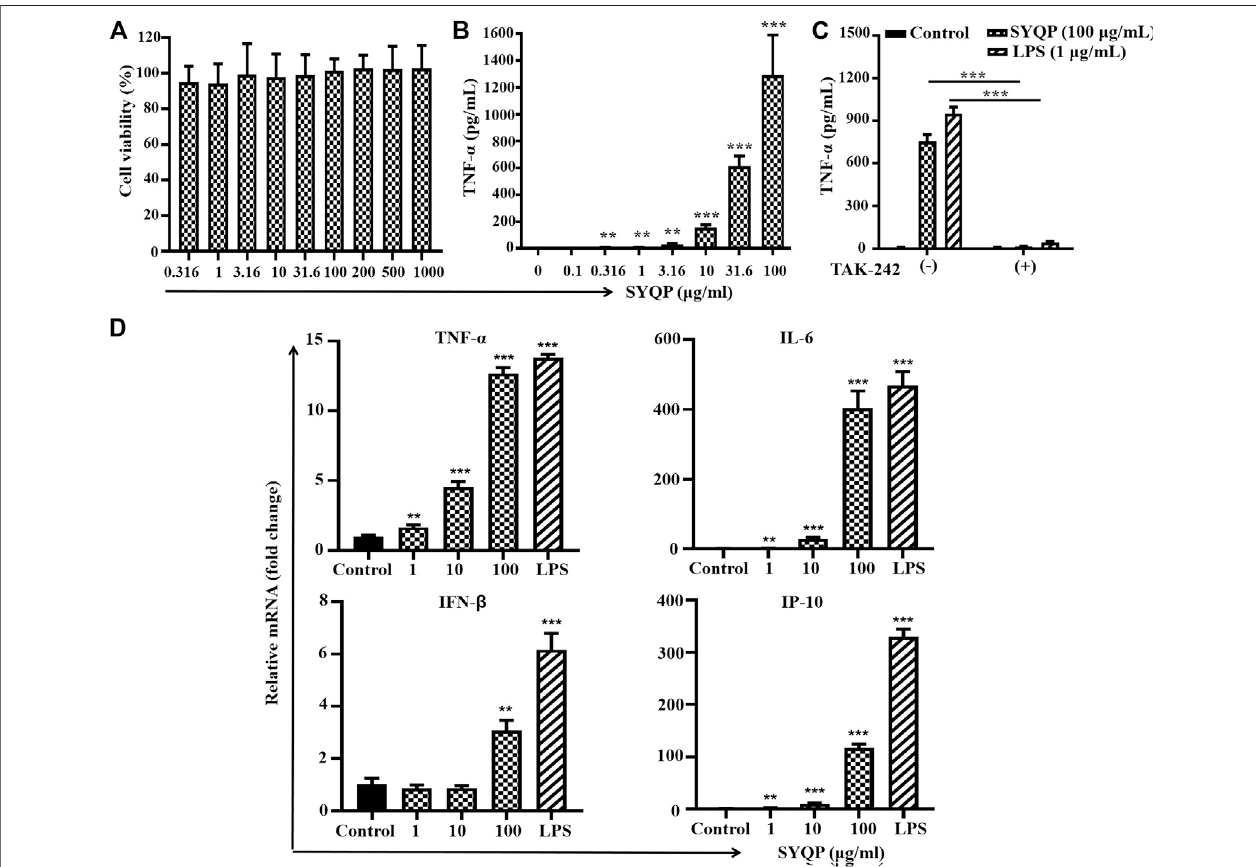
FIGURE2| SYQPstimulatedhumanTLR4inPMA-induced THP-1cells. (A) EffectsofSYQPonviabilityofTHP-1 cells.CellsweretreatedwithSYQPfor24 h,and cell viabilitywas evaluated byMTS assay. (B) SYQP increased the secretion ofTNF- α from THP-1 cells. Thecells were treated with SYQP at the indicated concentration for24 h.Cellculturemediumwascollected,andthesecretionlevelsofcytokinesweredetectedbyELISA.*** p < 0.001vs.control(theconcentrationofSYQPwaszero). (C) TLR4 antagonist TAK-242 decreased the secretion of TNF- α promoted by SYQP. The cells were treated with 100 μ g/ml SYQP alone or combined with TAK- 242 for 24 h. LPS at 1 μ g/ml was used as a positive control. Cell culture medium was collected, and the secretion levels of TNF- α were detected by ELISA. *** p < 0.001 vs. cells treated without TAK-242. All of the results are presented as the mean ± SD ( n (cid:2) 3). (D) SYQP induced mRNA expression of both MyD88-dependent and TRIF- dependent cytokines in THP-1 cells. The cells were treated with 1, 10, 100 μ g/ml SYQP or 1 μ g/ml LPS for6 h. After that, mRNA wasisolated,and the gene expression levels of cytokines were determined by real-time PCR. The results are presented as the mean ± SD ( n (cid:2) 3). ** p < 0.01, *** p < 0.001 vs.